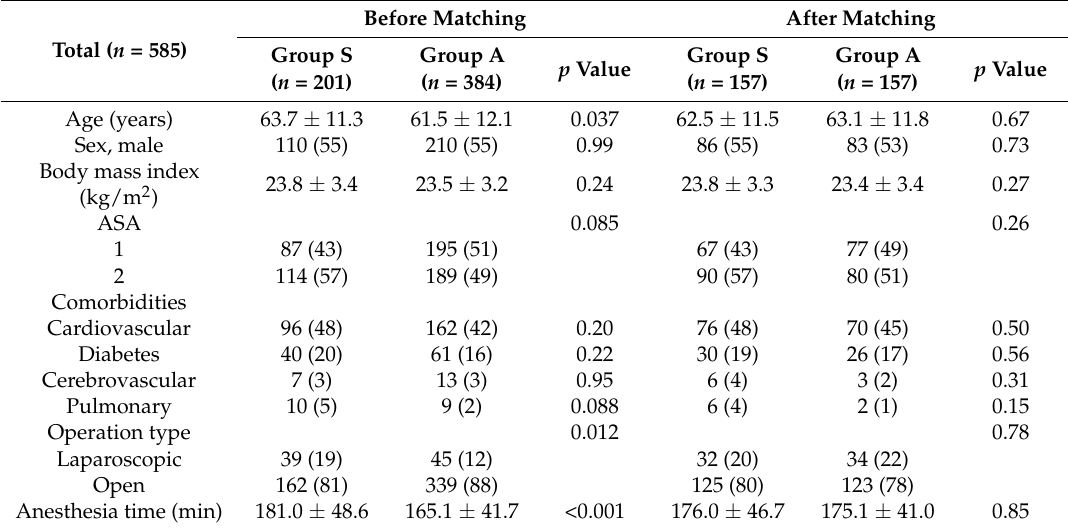
Table 1. Baseline characteristics.